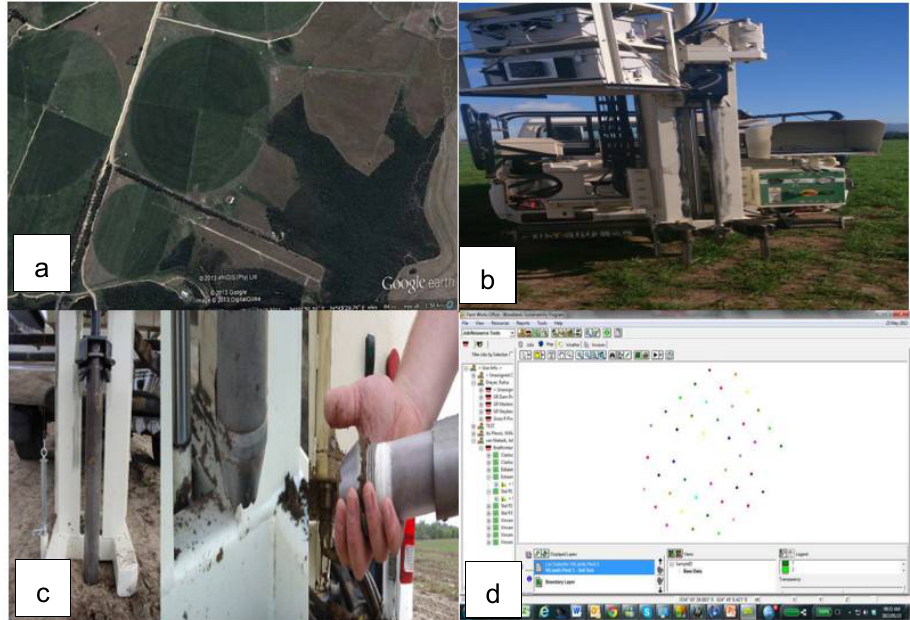
Figure 2. Google Earth to locate farms ( a ), Veris P4000 ( b ), core sampler ( c ), and sampling points under center pivot ( d